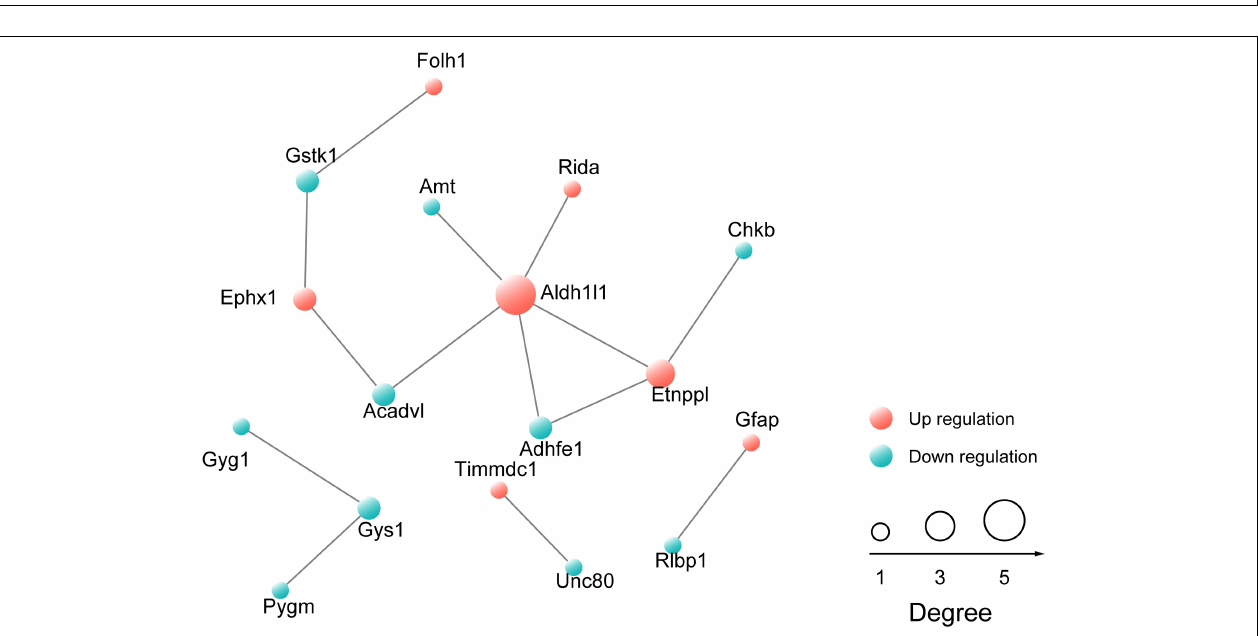
FIGURE 4 | Protein-protein interaction (PPI) network of proteins that are differentially expressed in the mPFC. The network was generated using the STRING database. The red sphere represents upregulated proteins and the blue sphere represents downregulated proteins.